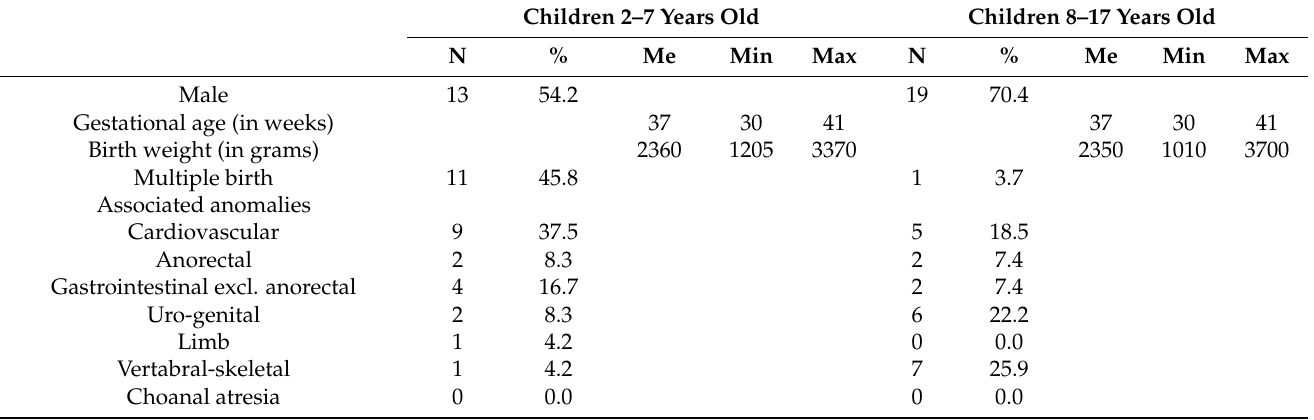
Table 1. Presentation of families responding to the EA-QOL-questionnaires for children aged 2 to 7 years ( n = 23) and children aged 8 to 17 years ( n =